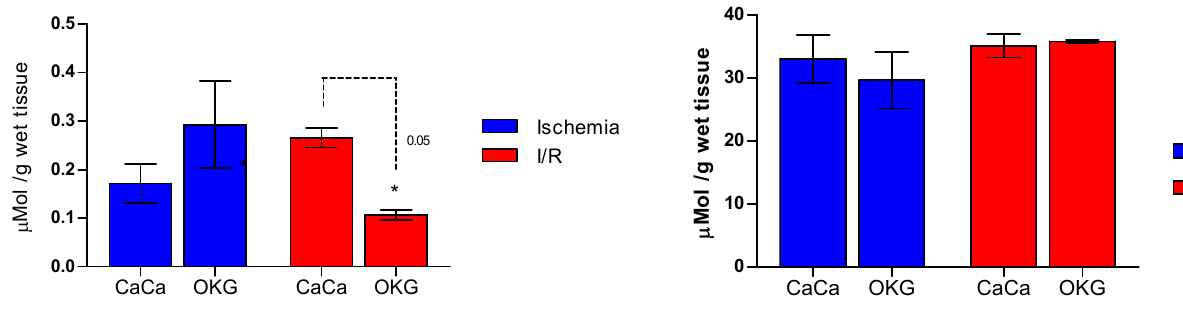
FIGURE 4 - Tissue lactate levels (micromoles per gram of fresh tissue) in samples from CaCa and OKG-pretreated rats. Bars represent mean±SD of ischemia (blue bars) and reperfusion (red bars) groups at the end of the ischemia (30 min) and reperfusion (30 min). Lactate levels in OKG treated rats decreased significantly at the end of reperfusion compared with CaCa-treated rats by Student´s t test.